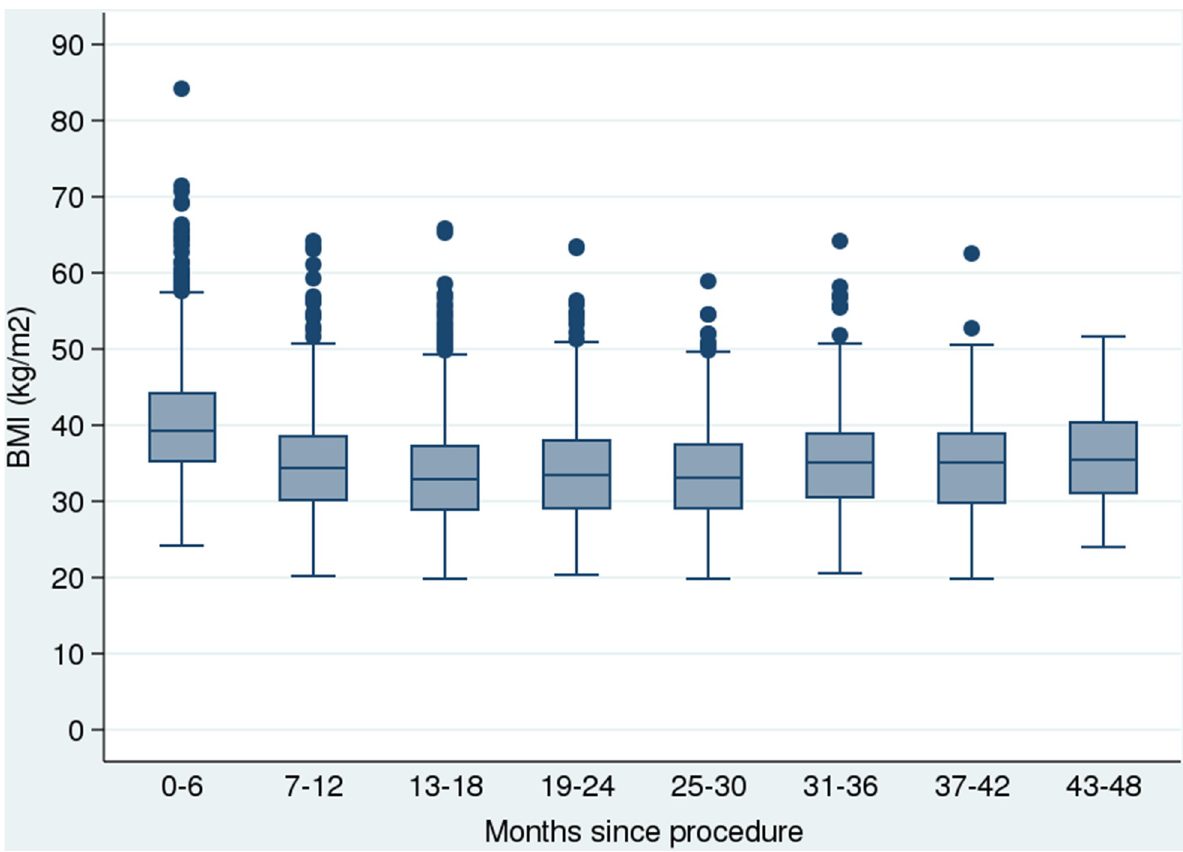
Fig 3. BMI in patients over time since bariatric procedure. Box and whisker plot (median and IQR) to illustrate BMI of patients among those with a follow-up visit during each time period from bariatric procedure. Whiskers represent the upper and lower adjacent values, with dots showing observations beyond these values. Numbers at each visit were the following: month 0 to 6 n = 2,133; month 7 to 12 n = 1,442; month 13 to 18 n = 1,112; month 19 to 24 n = 637; month 25 to 30 n = 633; month 31 to 36 n = 250; month 37 to 42 n = 189; month 43 to 48 n = 108. BMI, body mass index; IQR, interquartile